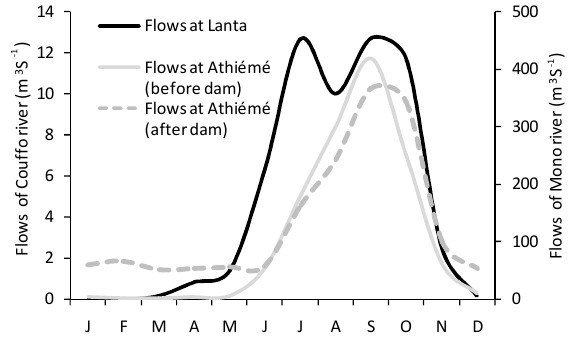
Figure 3. Mean monthly flow of the Mono River at Athiémé